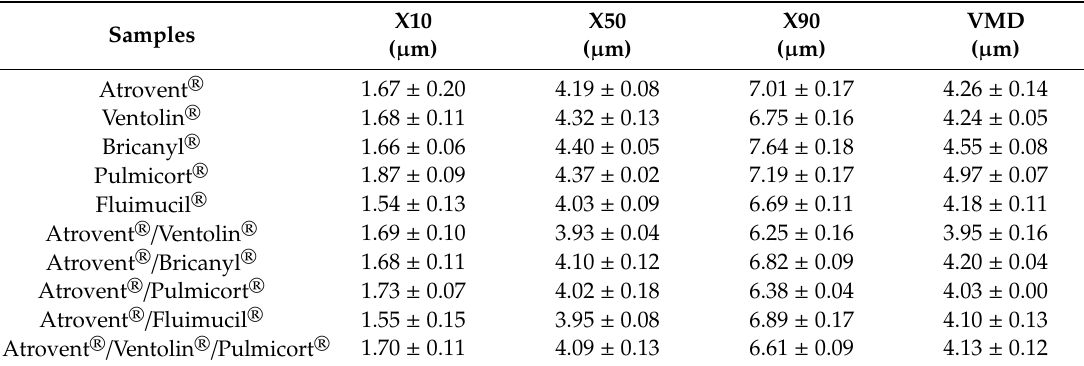
Table 3. X10, X50, X90, and VMD of test samples.